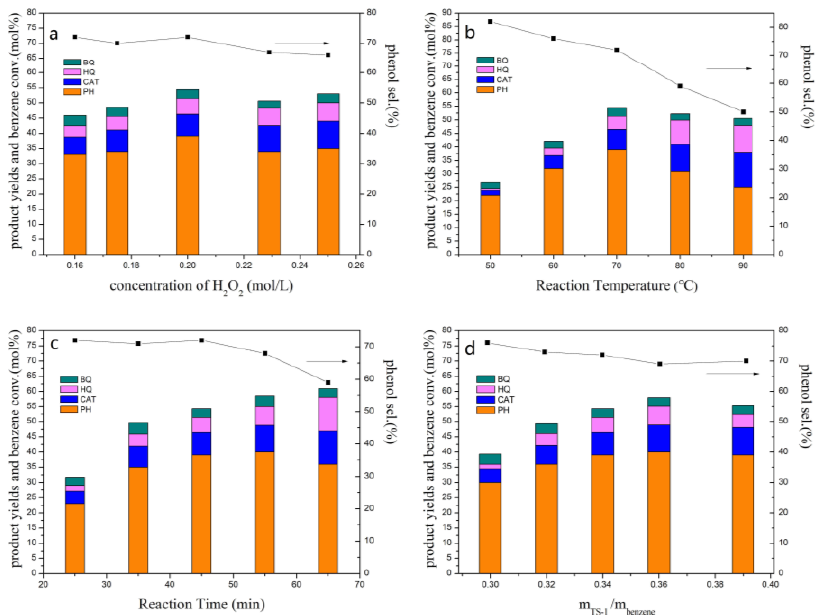
Figure 1. The yield of products, the conversion of benzene, and the selectivity of phenol. Reaction conditions: 5.6 mmol C 6 H 6 , 40.0 mL H 2 O: ( a ) The effect of concentration of H 2 O 2 , m TS-1 /m benzene = 0.34,